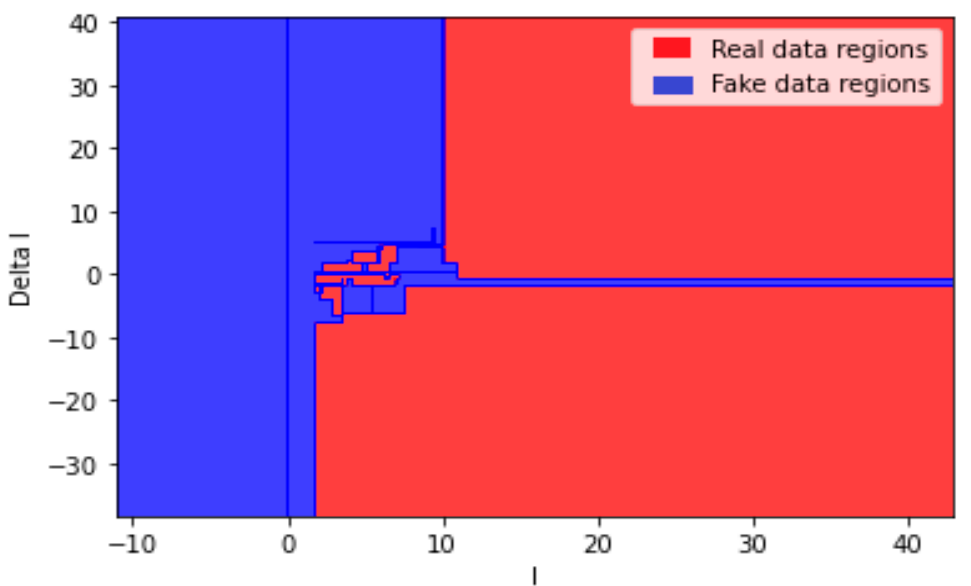
Figure 8. The classified regions of the real and fake data based on the decision tree.